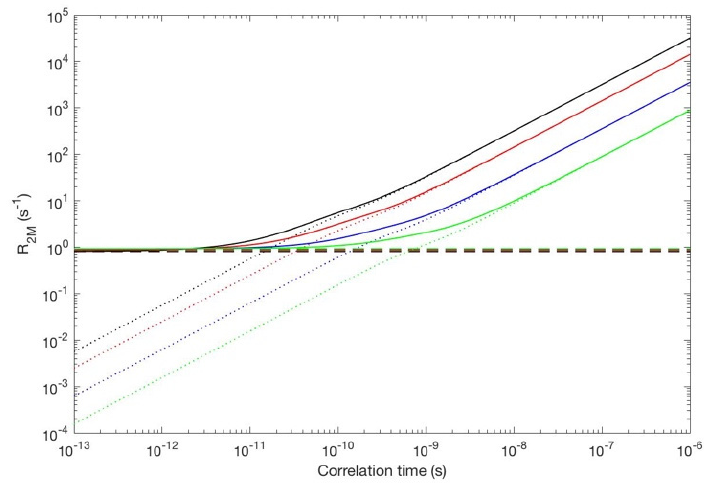
Figure 11. Additional Curie-spin-like contribution to the transverse relaxation of a 1 H nucleus 10 Å away from a dysprosium(III) complex where the magnetic susceptibility (with eigenvalues 5 × 10 − 30 , 5 × 10 − 30 , and 1 × 10 − 30 , respectively) can switch between three orthogonal orientations, with a correlation time ranging from 1 × 10 − 13 to 1 × 10 − 6 , evaluated at 28.2 T (black), 18.8 T (red), 9.4 T (blue), 4.7 T (green). The Solomon relaxation evaluated with an electron relaxation time of 1 × 10 − 13 s, at the same fields—which does not depend on the correlation time of the susceptibility reorientation and is, therefore, constant—is also reported.